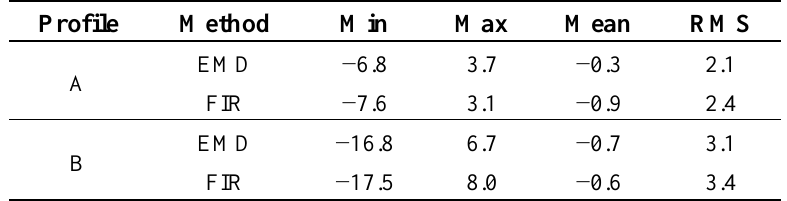
Table 2. Statistics of the differences for external accuracy (units: